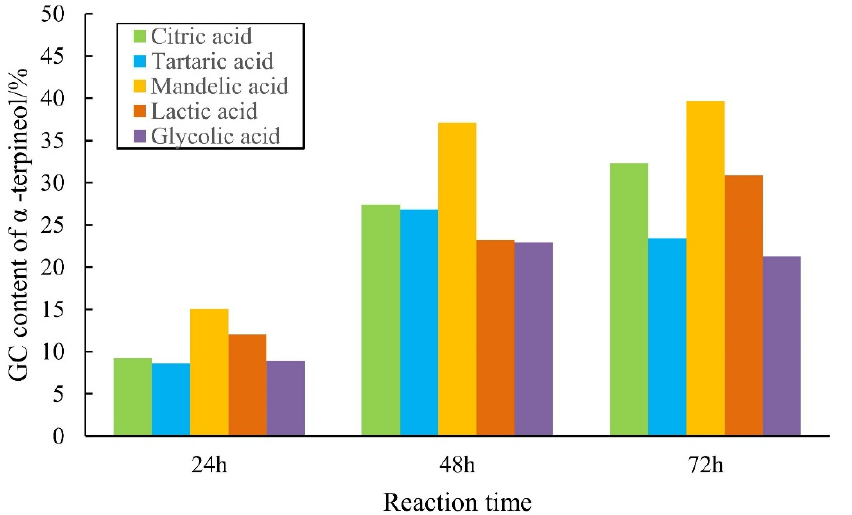
Figure 3. Comparison of alpha-terpineol content with AHA as the catalyst. Note: The mass ratio of alpha-pinene, water, and AHA was 1:1:1 at 70 °C.